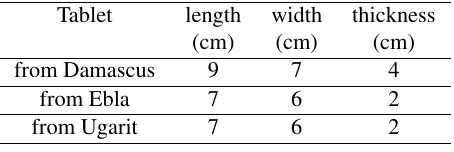
Table 1: Tablet approximate main dimensions